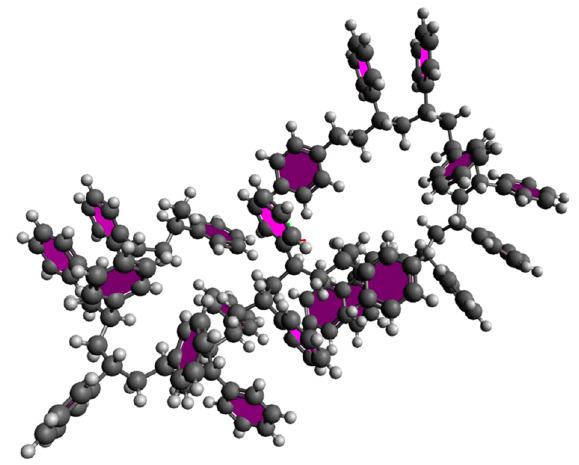
Figure 2. Polystyrene with 322 atoms.